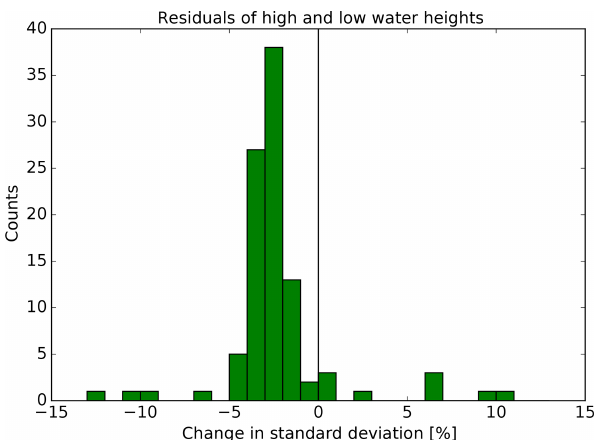
Figure 9. Histogram of the change in the standard deviation of the residuals of high- and low-water heights for all 98 tide gauges.